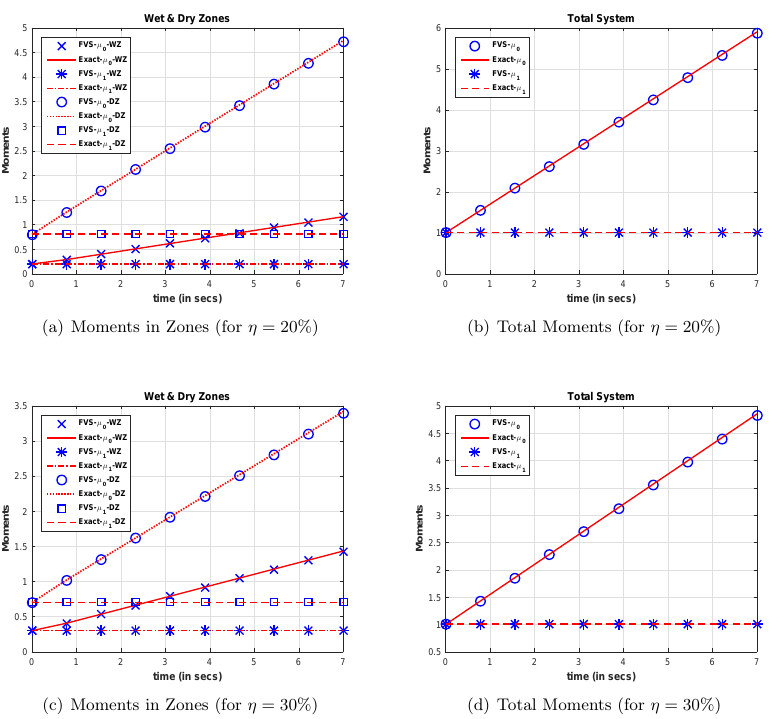
Figure 4: Different order moments for product kernel using various values of η . Figure 4. Different order moments and number density for the product